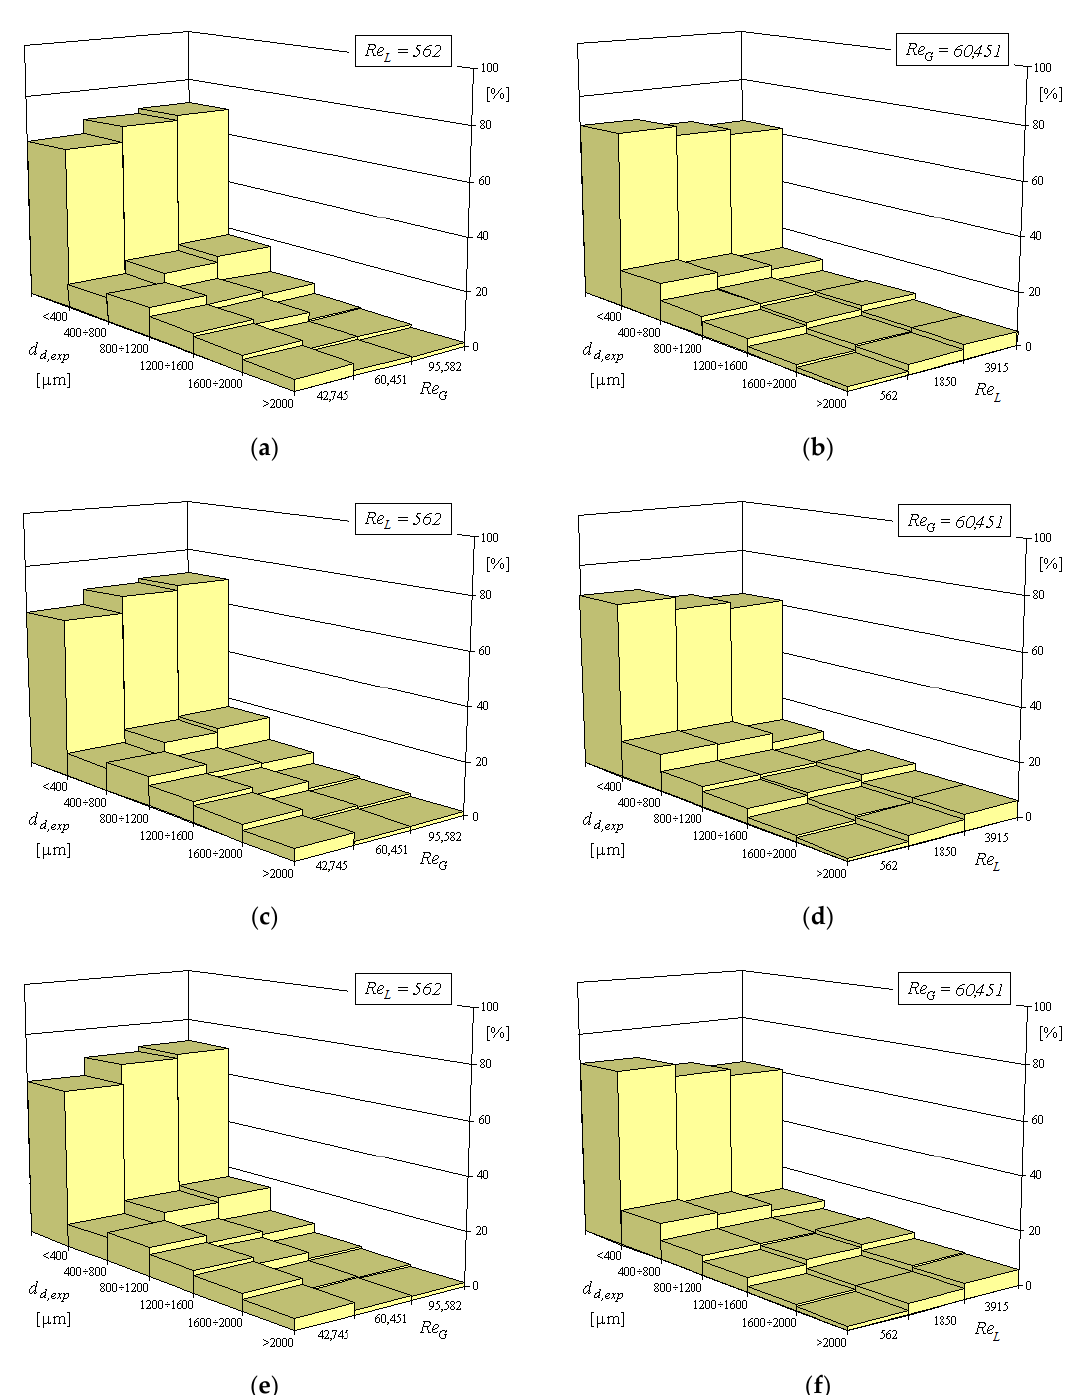
Figure 5. The distribution of drop size in the air–polymer solution system for the confusors studied ( a,b ) K 0 ; ( c,d ) K 1 ; and ( e,f ) K 2 .